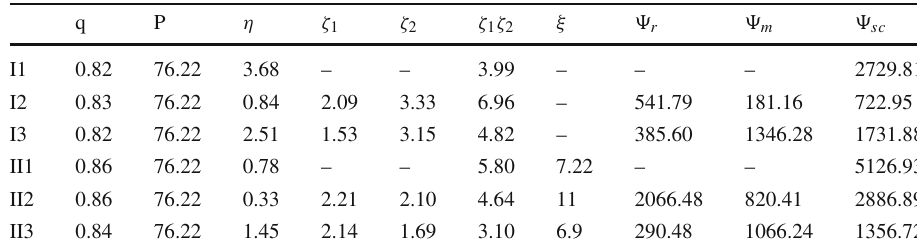
Table 5 Optimum